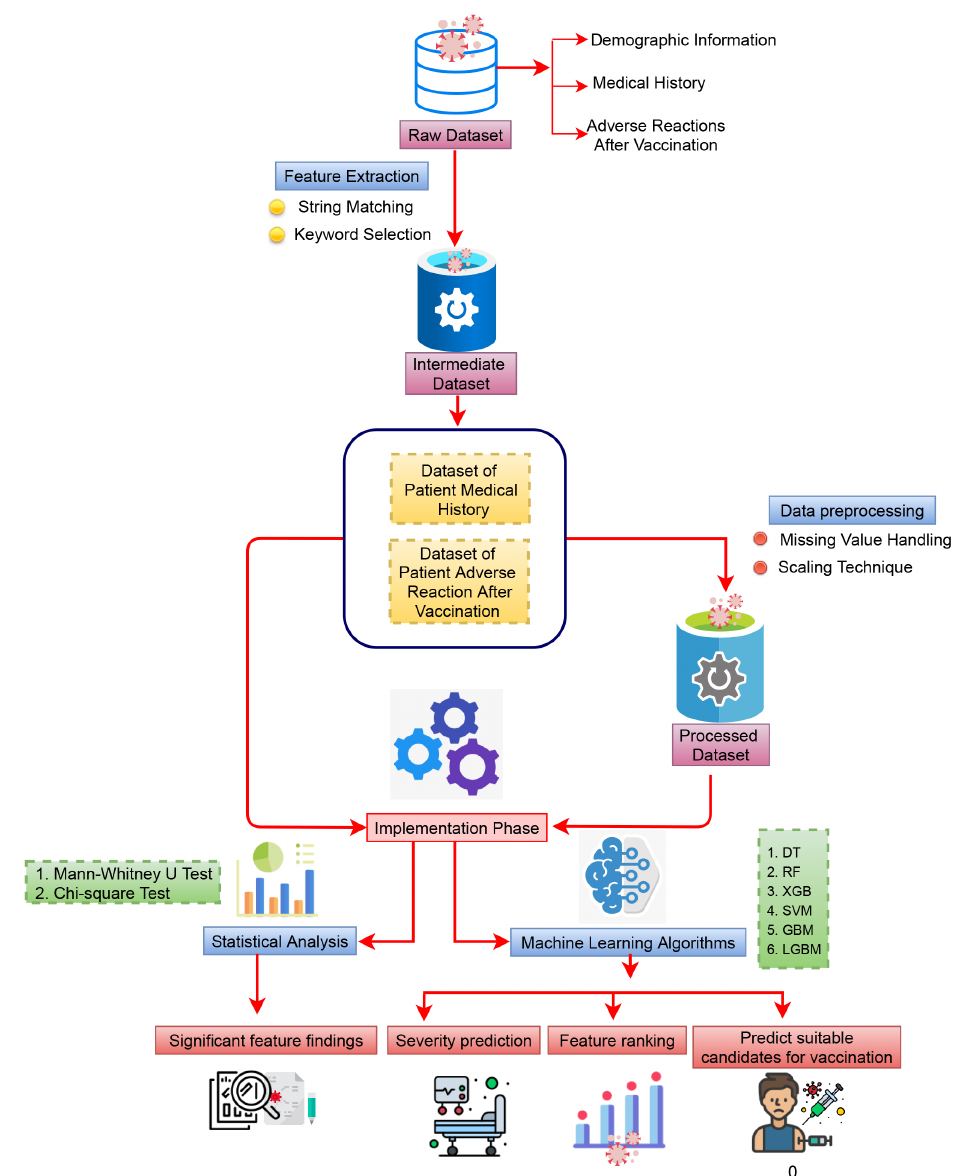
Figure 1. The schematic diagram of the overall workflow including data processing, data division, analysis using statistical and machine learning methods, and, at the end, performance evaluation with finding significant